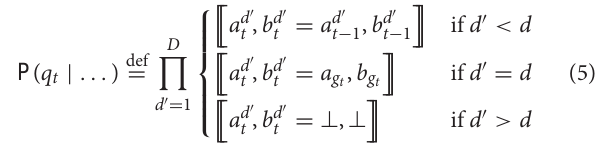
= 1) and no-match ( m ℓ t and base b g t t